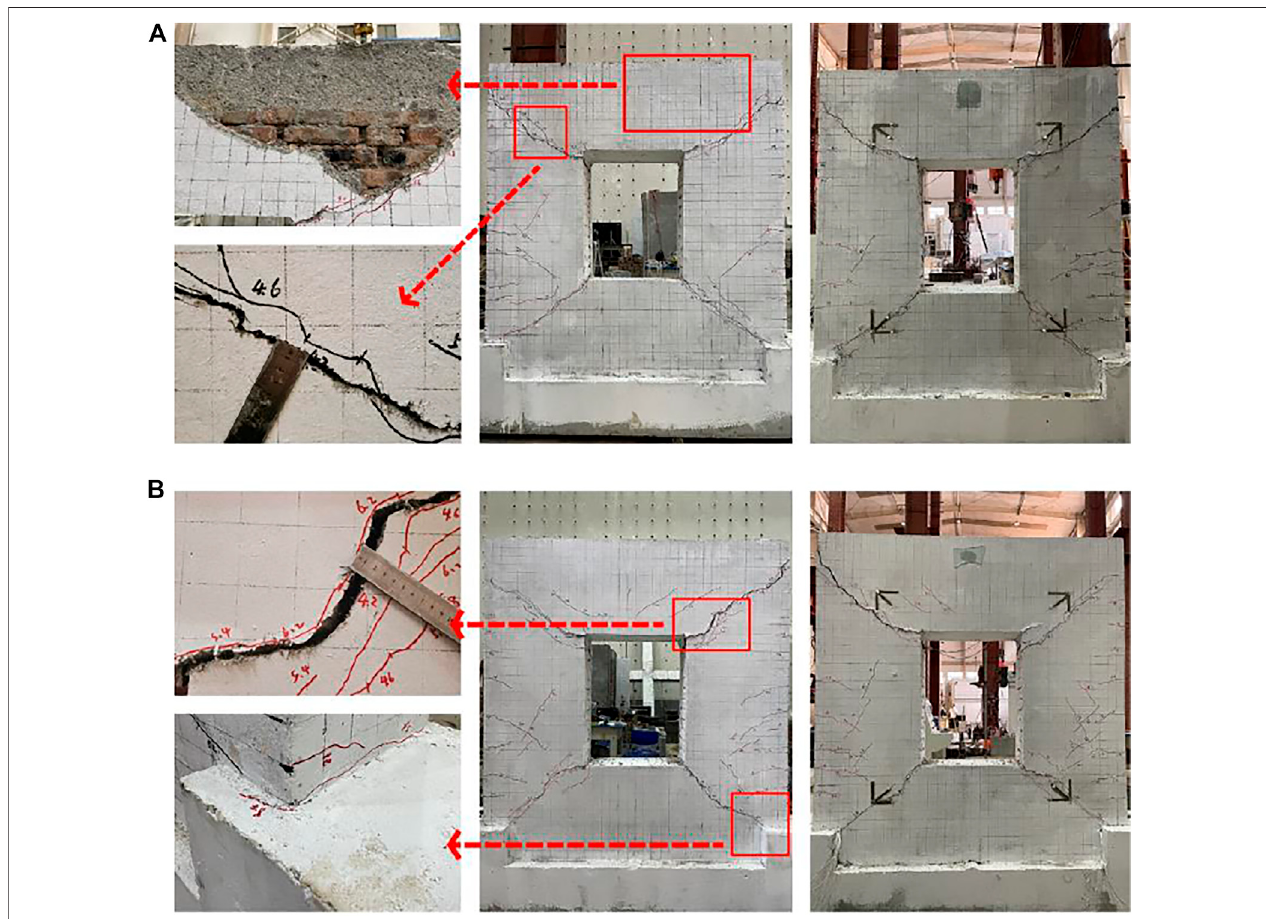
FIGURE 7 | Failure mode and crack pattern for DRMW-3 and DRMW-4 at ultimate displacement (A) DRMW-3 (B) DRMW-4.